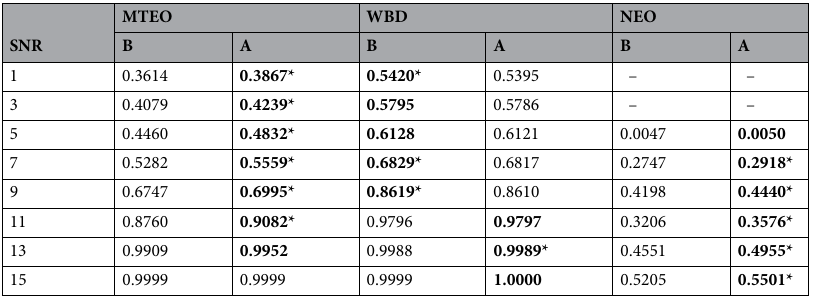
Table 1. The effect of the proposed adaptive detection on different spike detection procedures using synthesized dataset. First, different detection procedures are applied on the raw synthesized data with different SNRs. Then, the resulted spike wave-shapes and their corresponding occurrence times are fed to the adaptive detection procedure. Finally, the precision before and after the adaptive detection procedure is calculated at a fixed recall rate. Here, B and A indicate the precision before and after applying adaptive detection, respectively. Significant differences ( p < 0 . 01) are marked with star. The results indicate an improvement over both MTEO and NEO. However, in WBD, there exists a slight improvement in high SNRs. Thus, the proposed adaptive detection procedure could be applied to different detection procedures to improve the final results. In MTEO method, the threshold parameters of statistical filtering are fitted based on the simulated